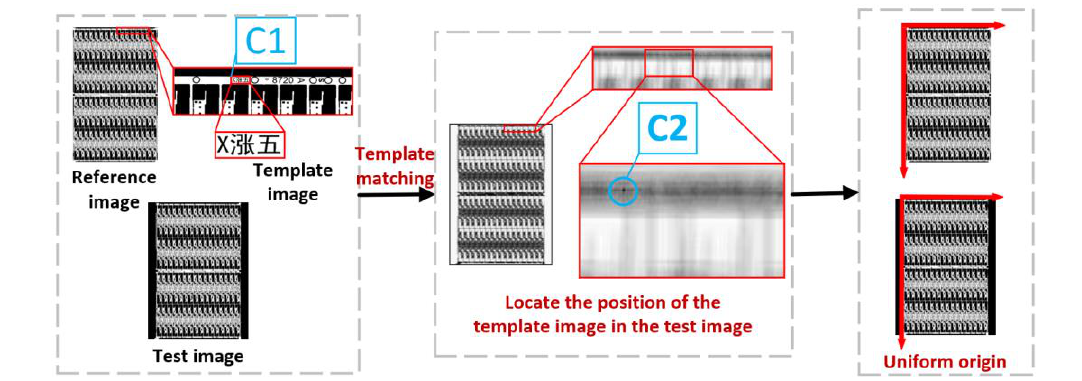
Figure 3. Coarse registration flowchart. The Chinese text in the figure is the mark on the circuit board, which is usually used for positioning.